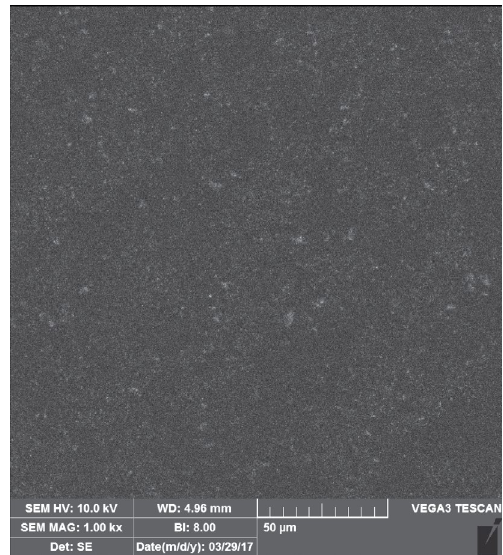
Figure 7. SEM micrograph of the PA7